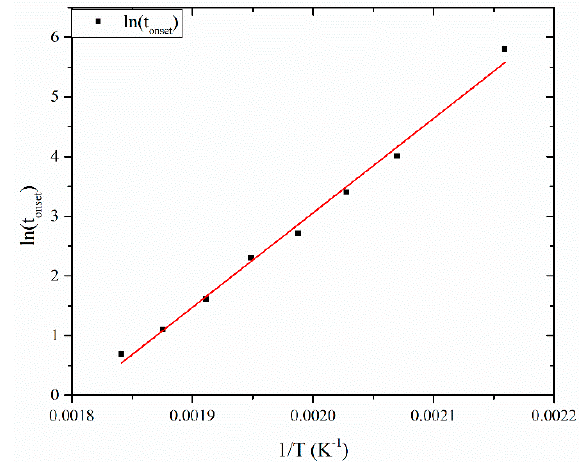
Figure 10. Arrhenius plot of t onset versus stabilization temperature.